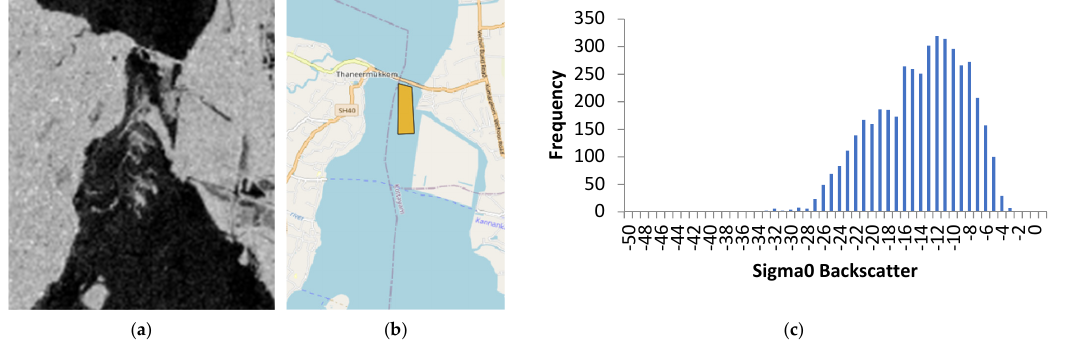
Figure 5. Image from 19 January 2020 in Sentinel-1 VV Channel showing water hyacinth on surface of Vembanad Lake. ( a ) VV intensity, ( b ) polygon used for histogram and ( c ) histogram of pixels in the polygon (Senintel-1, credits: ESA).